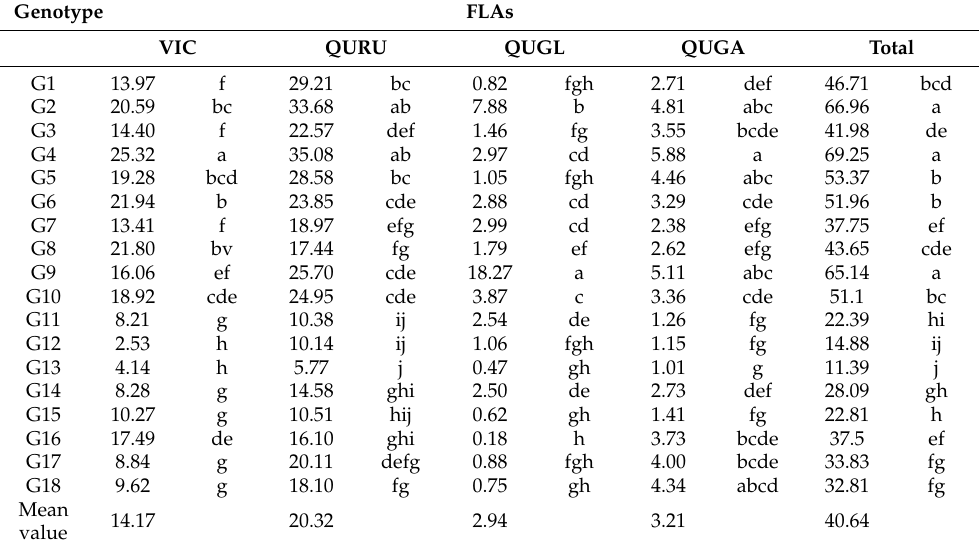
Table 5. Content (mg/100 g of dw) of flavonoids (FLAs) of 18 native Greek rock samphire genotypes (for abbreviations and origin, see Table 1). Different letters in the same column characterize significant differences among genotypes according to Tukey’s test for p ≤ 0.05.